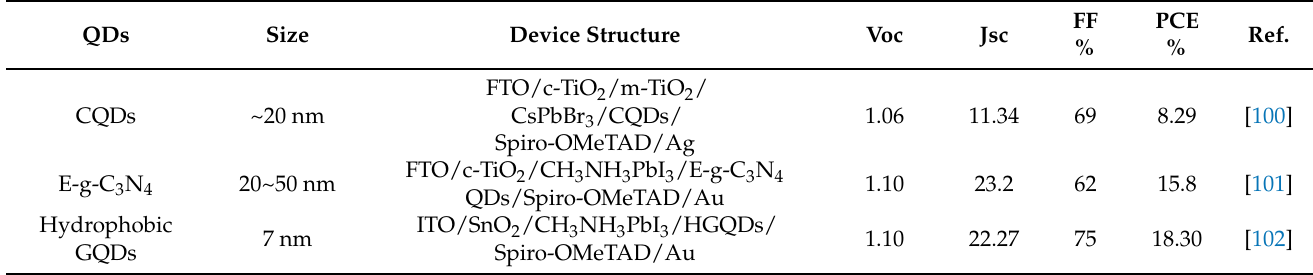
Table 4. Details of CQDs and GQDs as the perovskite/HTL interface